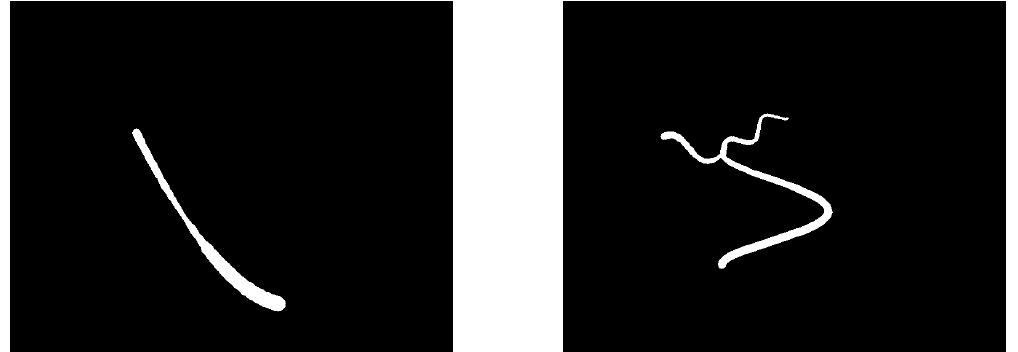
Figure 5. In silico simulation of two vessel segmentations. Left : Section of a parabola with a stenosis. Right : Bifurcation including sections of two Gaussian bells and a sinusoidal.